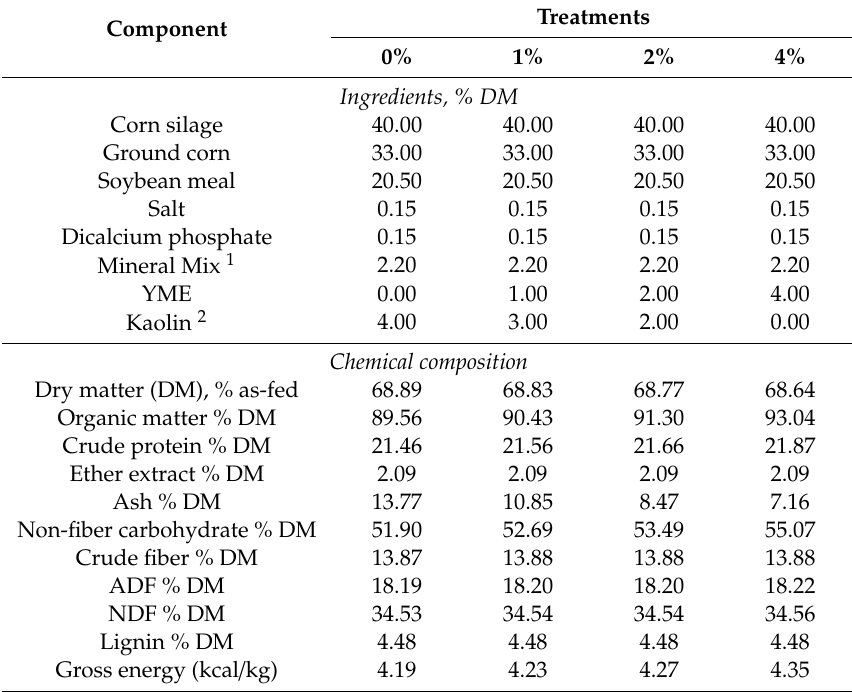
Table 1. Ingredients and chemical composition of the experimental